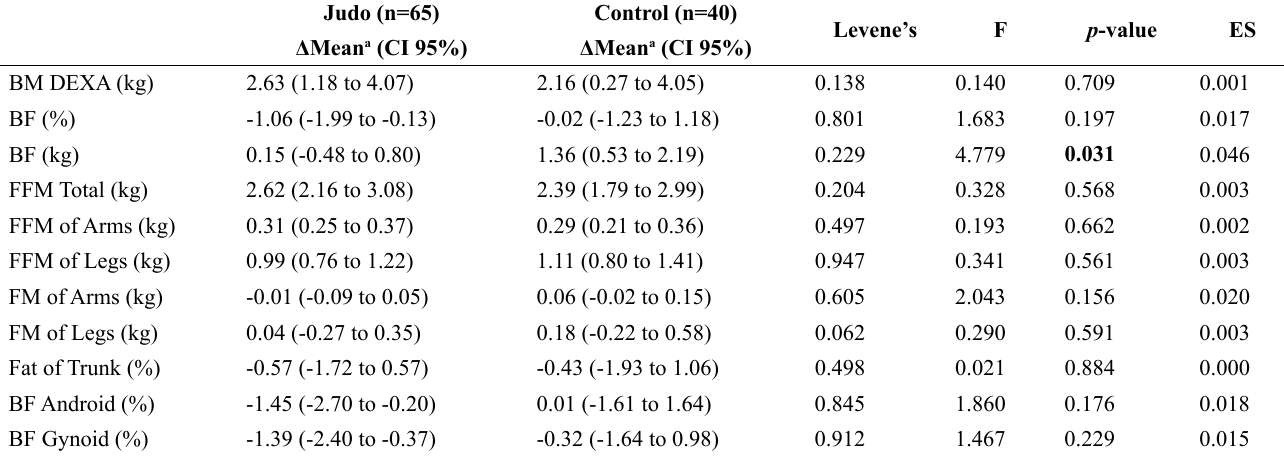
Table 2.Effect of Judo intervention on body composition in children and